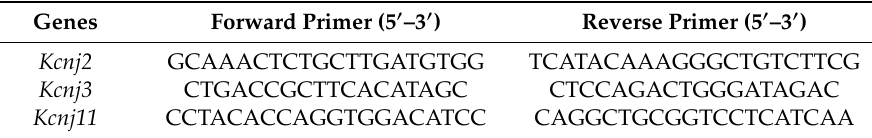
Table 1. List of primers for